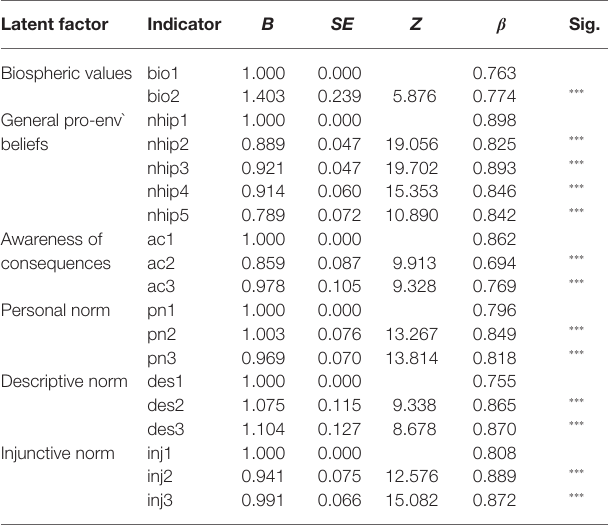
TABLE 2 | Parameter estimates from the six-factor CFA of Study